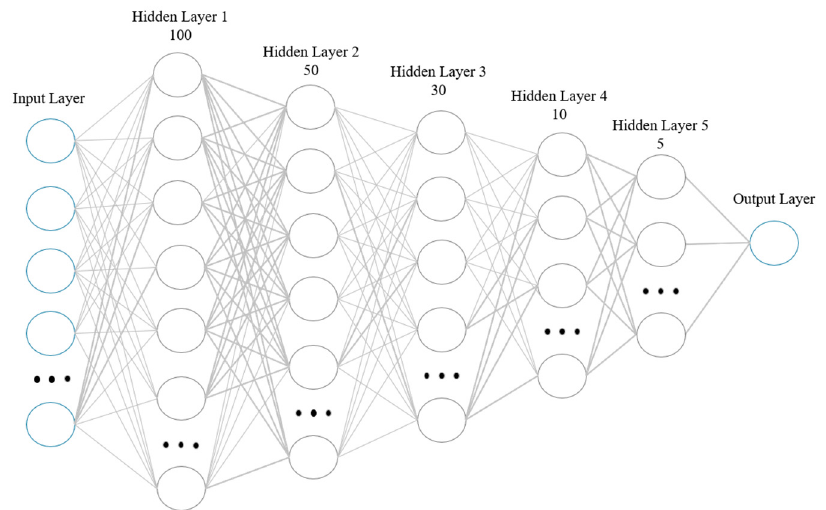
Figure 3. Uddin et al. DNN architecture [25] used in the study outperformed larger and more complex models with regularization built for comparison producing an F1 score of 0.92.